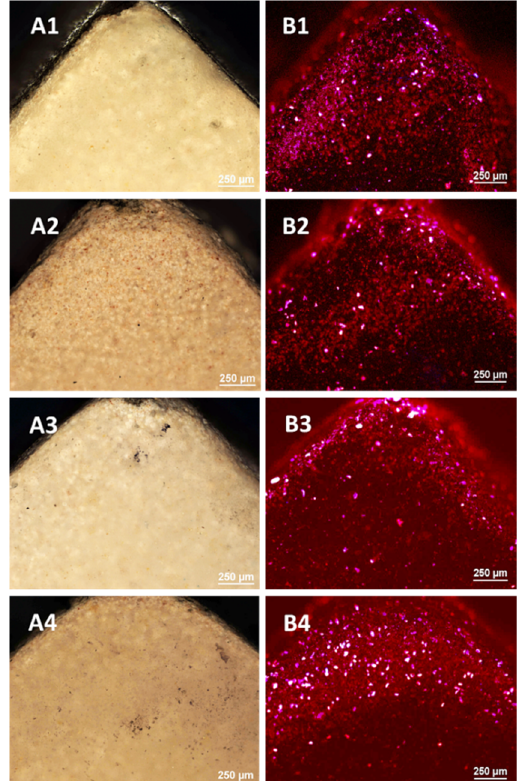
Figure 1. The micrographs of the surface of the porcelain samples made with the use of an optical microscope: ( A1 ) the control sample; ( A2 ) after irradiation with L1; ( A3 ) after irradiation with L2; ( A4 ) after irradiation with L3. Microphotographs taken from the surface of a porcelain sample using a confocal microscope with a laser wavelength of λ = 408 nm: ( B1 ) the control sample; ( B2 ) after irradiation with L1; ( B3 ) after irradiation with L2; ( B4 ) after irradiation with L3.